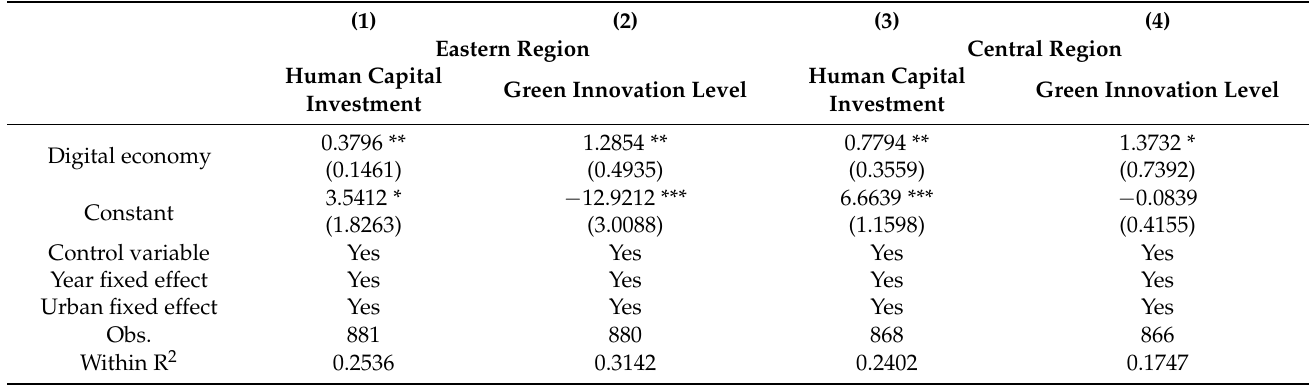
Table 7. Mechanism test results of east and central